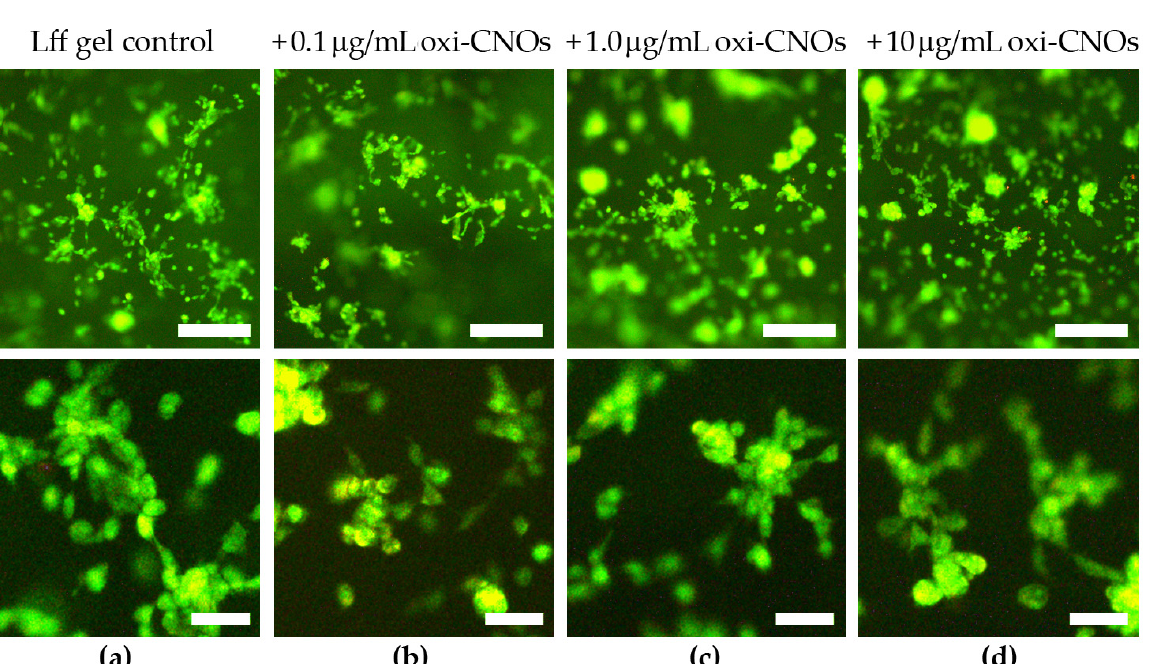
Figure 12. MTT metabolic assay on fibroblast cells grown on the plastic control (ctrl), the peptide gel without (Lff gel) or with increasing concentrations of oxi ‐ CNOs (+0.1, +1.0, or +10 μ g/mL oxi ‐ CNOs). No statistically significant (n.s.) difference was found between tested conditions ( p >0.05).